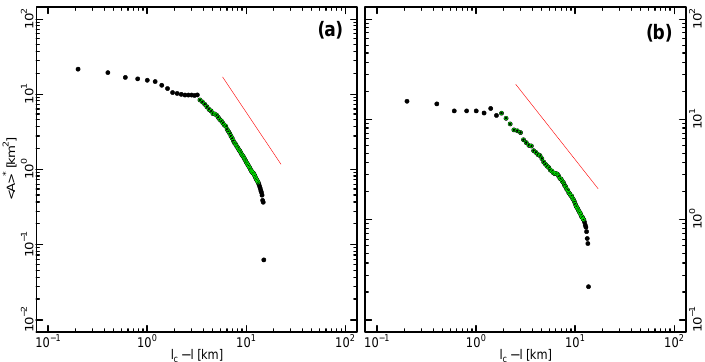
Figure 5. Fitting of the average size scaling for Austria ( a ) and Denmark ( b ). In both cases we have a unique clear peak in the curve of (cid:104) A (cid:105) ∗ against l . The red lines represent the exponents of the function f ( x ) = c · x a fitted to the green highlighted parts. Fittings yields the parameter a ≈ − 1.97 for Austria and a = − 1.25 for Denmark.